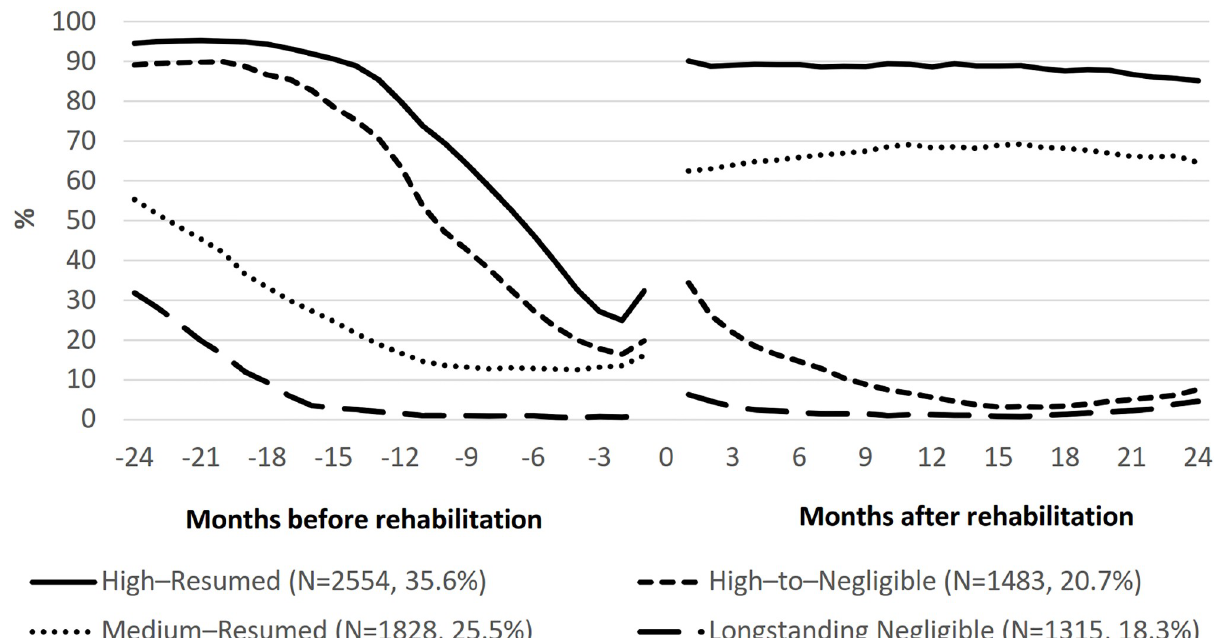
Fig 1. Four identified trajectory groups of work participation over the period of two years before and two years after vocational